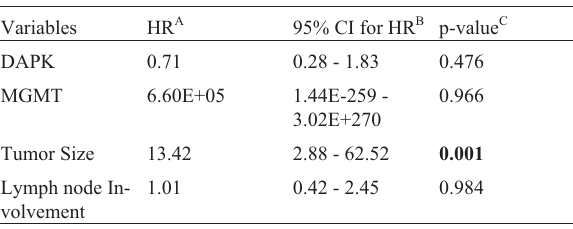
Table 4 - Multivariate Cox regression analysis of prognostic features and DAPK and MGMT hypermethylation. Variables